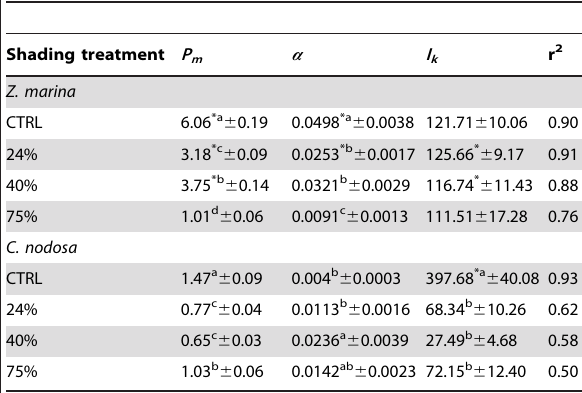
Table 1. Photosynthetic parameters obtained from the adjustment of the model equation of Smith and Talling [15] [16] to the observed P-E data for Zostera marina and Cymodocea nodosa .